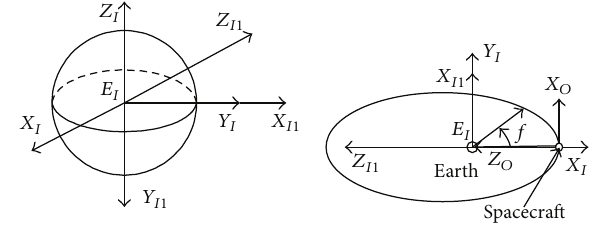
Figure 2: The related reference